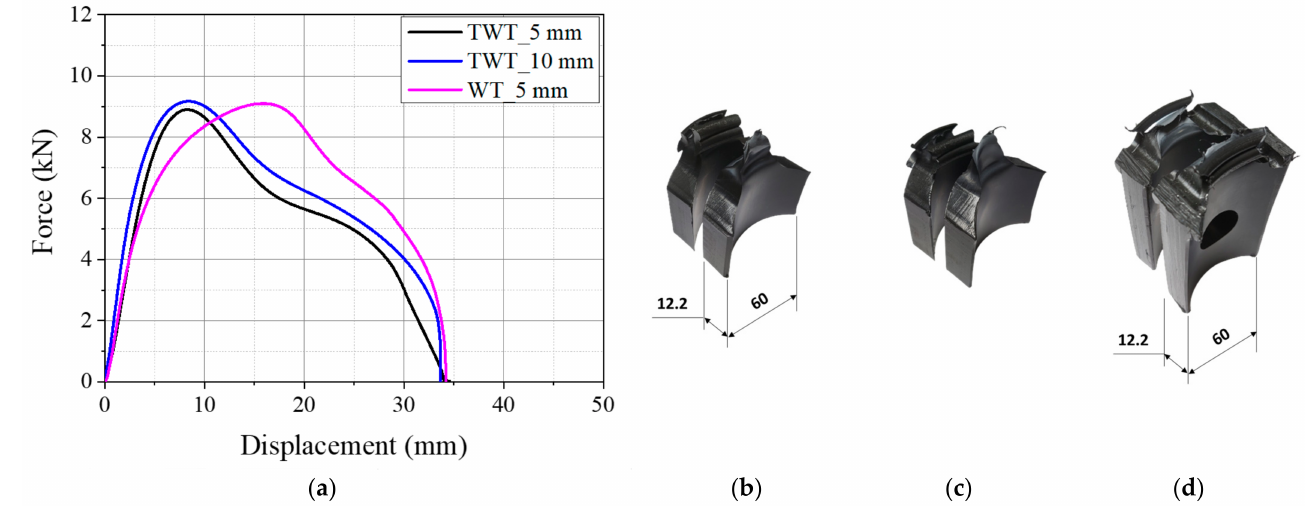
Figure 6. Results of 110 SDR 9 (Type A specimens) pipe BF joint (unit: mm): ( a ) load–displacement curves; ( b ) TWT_5 mm; ( c ) TWT_10 mm; ( d ) WT_5 mm fusion zone notch radius.